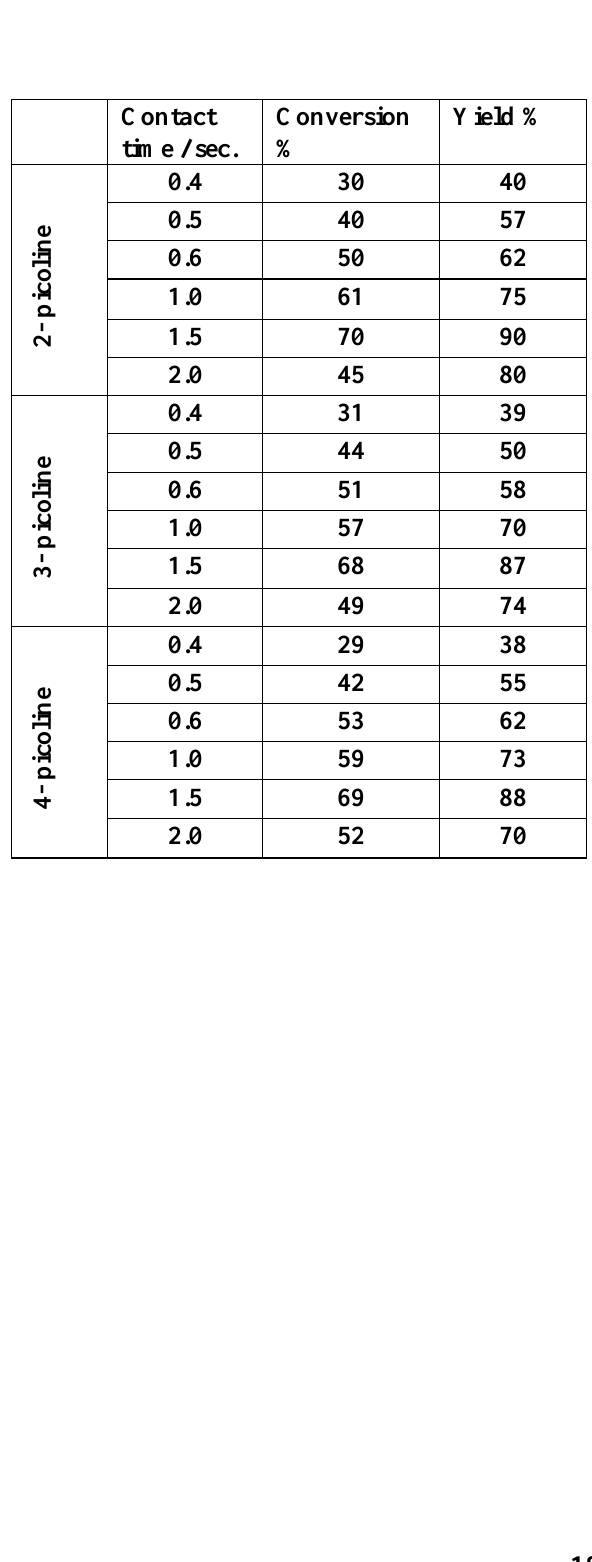
Table1C Effect of the contact time (sec.) Table 1D effect of temperature °C on on the %conversion and %yield of 2-,3- and 4- the % conversion of 2-,3- and4- picolines to Nicotinic Acid picolines to Nicotinic